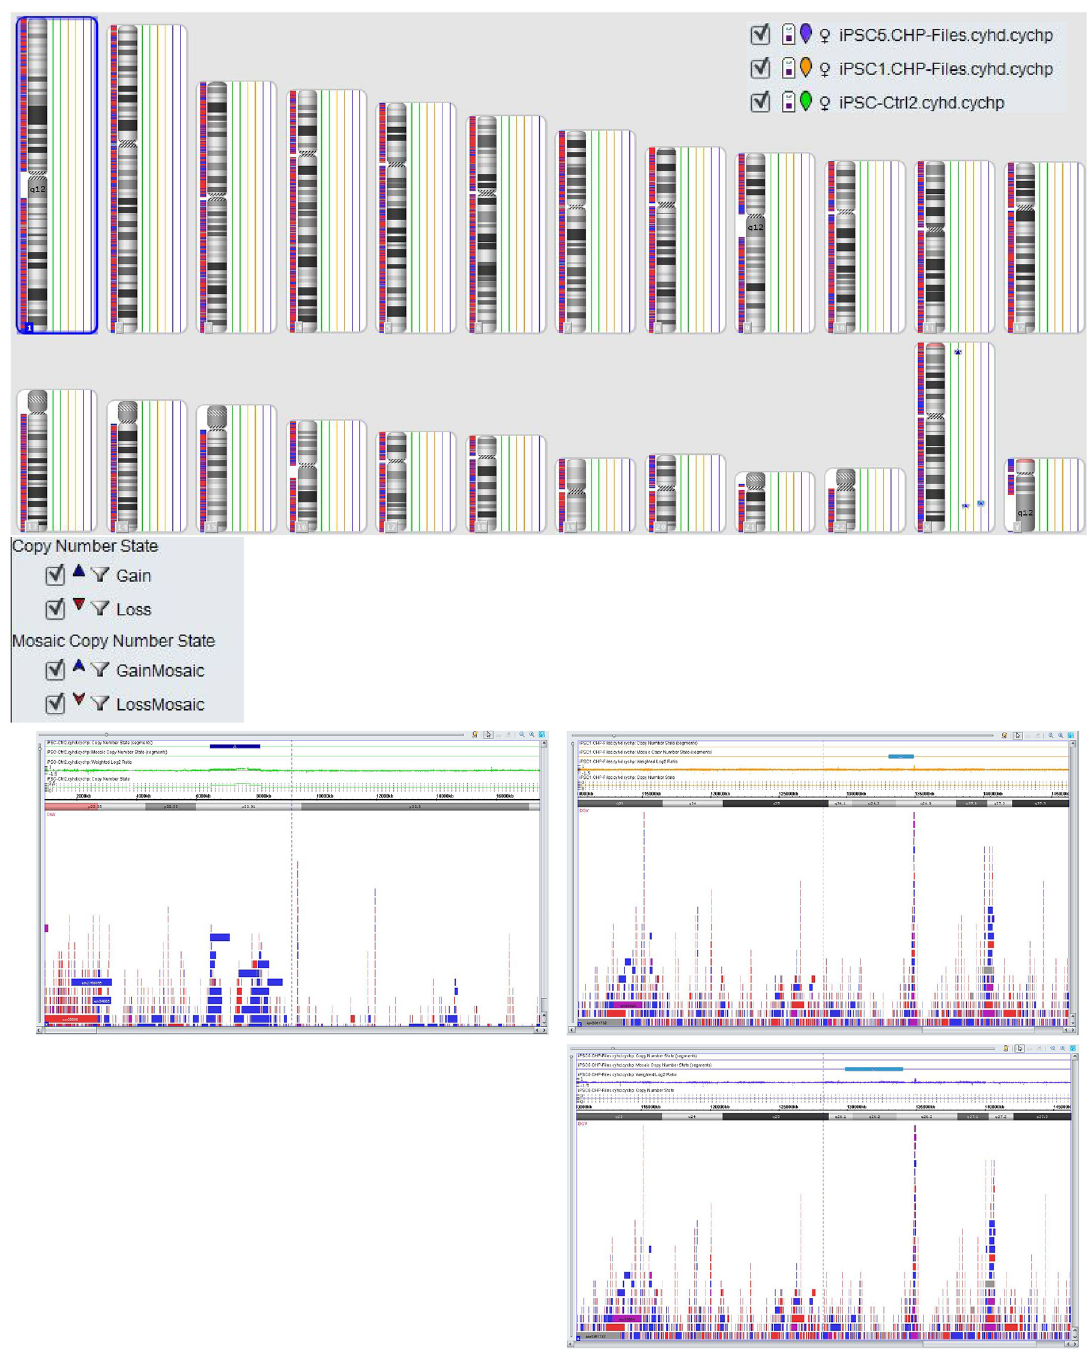
Fig 6. Molecular karyotyping. ChAS 4.0 representation of chromosomal abnormalities measured by Affymetrix cytoscan HD array of lines iPSC1, iPSC5 and iPSC-Ctrl2. Abnormalities are shown as insertion (red marks) or deletions (blue marks) (15kb) at their correspondent chromosomal